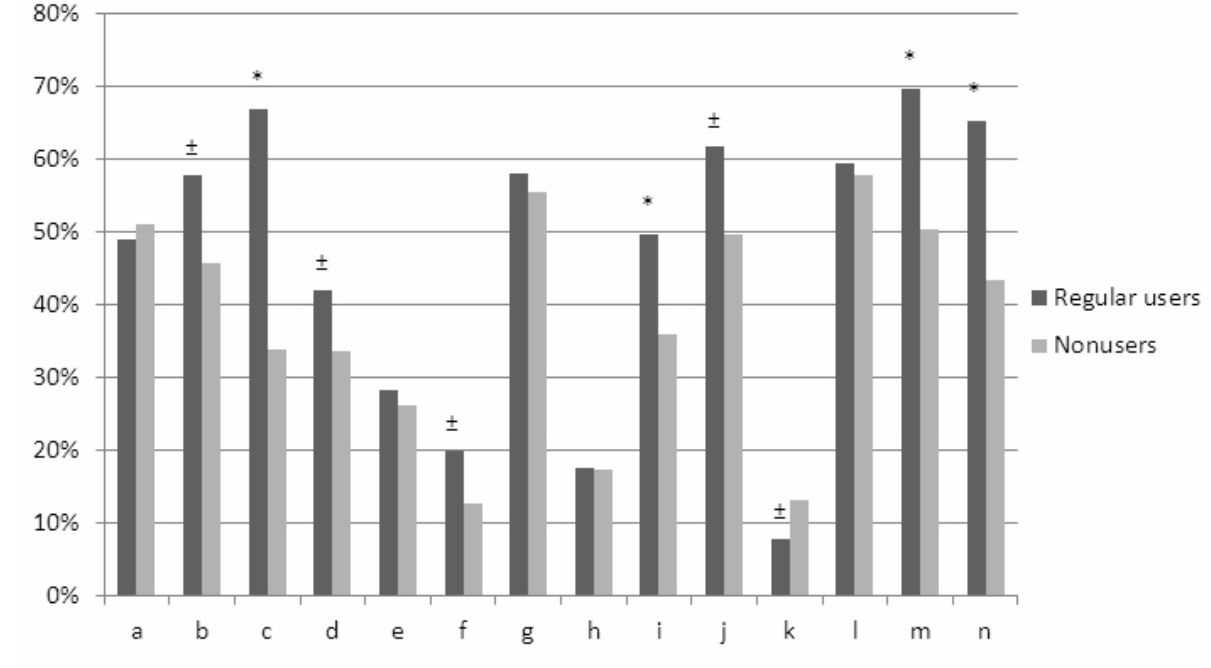
Figure 3. Differences between regular users (n=413) and nonusers (n=758) regarding usefulness of functionalities (very useful or useful) that could be added to the Web portal. (a) Automatic signal to physician when uploading glucose diary, (b) automatic upload from glucose meter to portal, (c) adding insulin units to glucose diary, (d) links to websites with information about diabetes, (e) links to websites with lifestyle interventions, (f) portal on mobile device, (g) request for medication refills, (h) forum functionality, (i) printing functionality, (j) news sites about diabetes, (k) information in different languages, (l) information about medication and side effects, (m) reminder function about upcoming consultation, (n) using the portal for scheduling a consultation with physician. * P<.001; ±